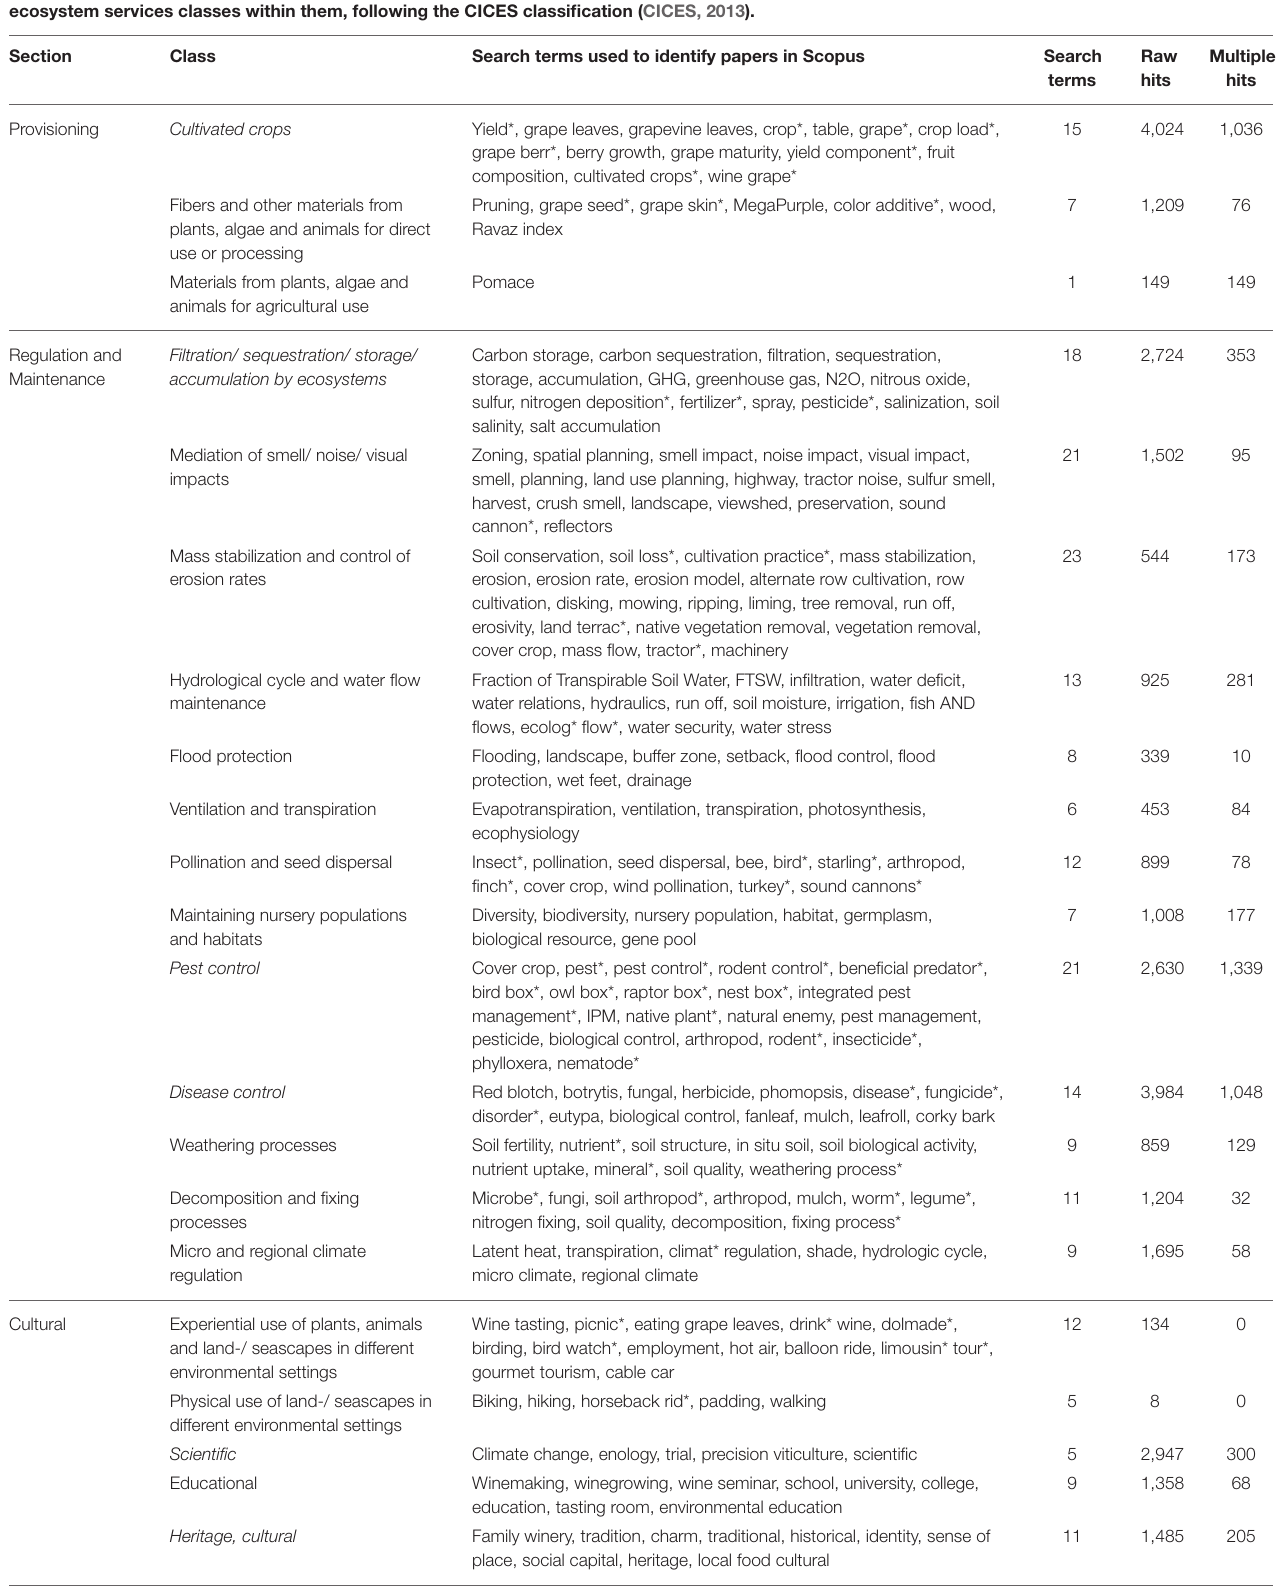
TABLE 1 | Search terms used to find peer-reviewed papers in Scopus on the three sections of ecosystem services in vineyards and 27 selected ecosystem services classes within them, following the CICES classification (CICES, 2013).